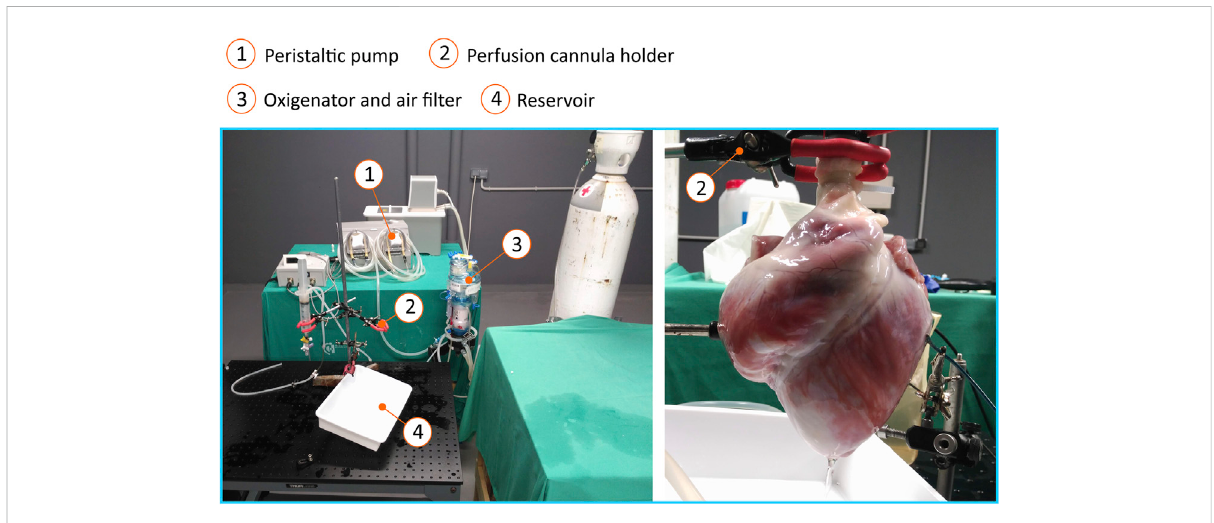
FIGURE 2 Langendorff perfusion system. The layout of the equipment (left) and the system used to suspend the heart (right) are